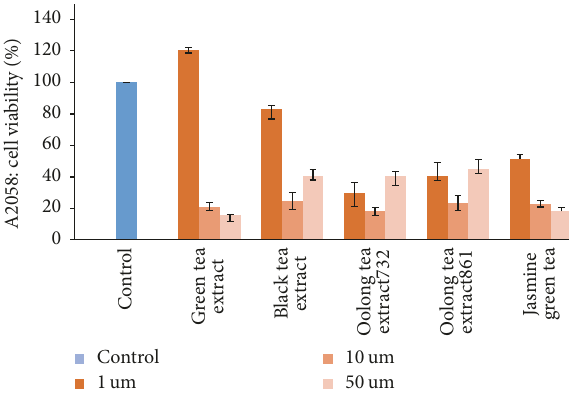
Figure 3: Effects of five extracts on cell viability of normal human cell and malignant melanoma cell according to MTT assay. Percent- age of cell viability was measured in A375 cultured with 1 𝜇 m, 10 𝜇 m, and 50 𝜇